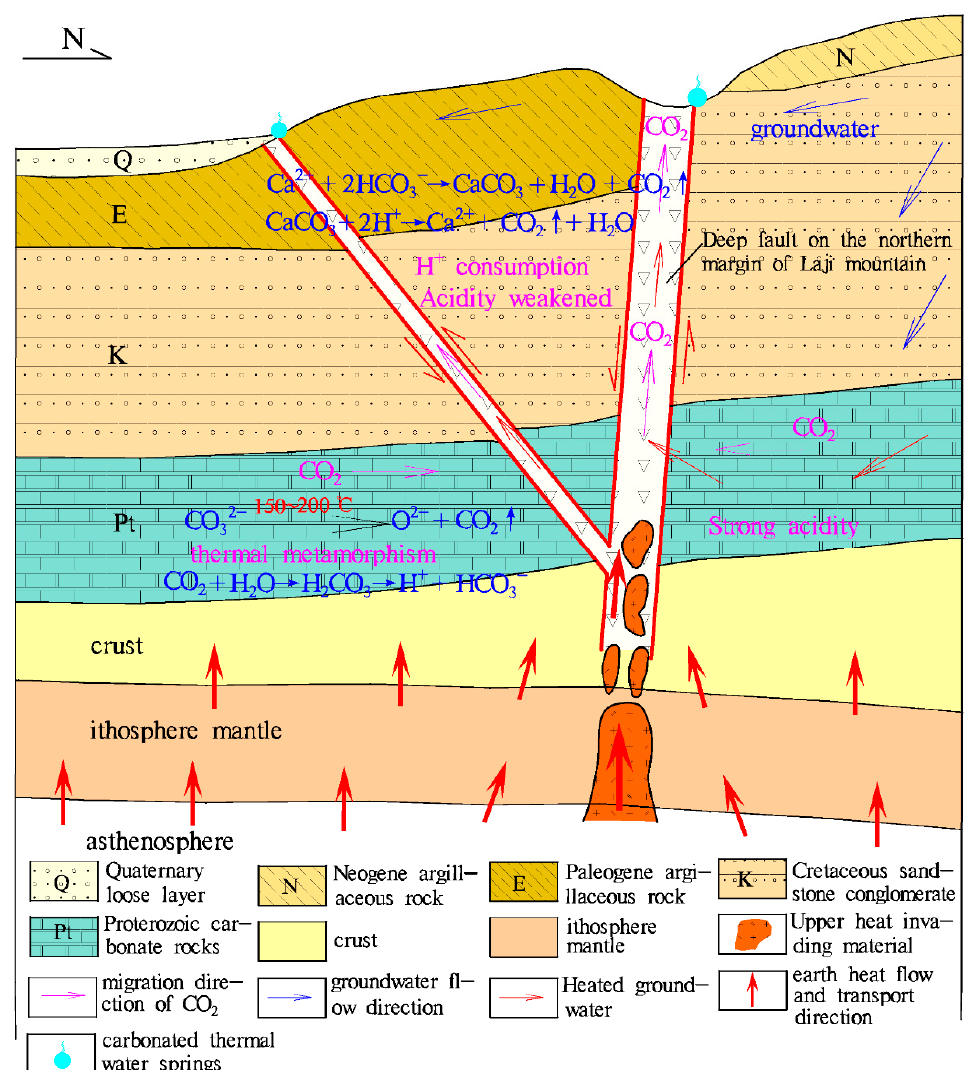
Figure 7. Typical CO 2 migration and accumulation model.